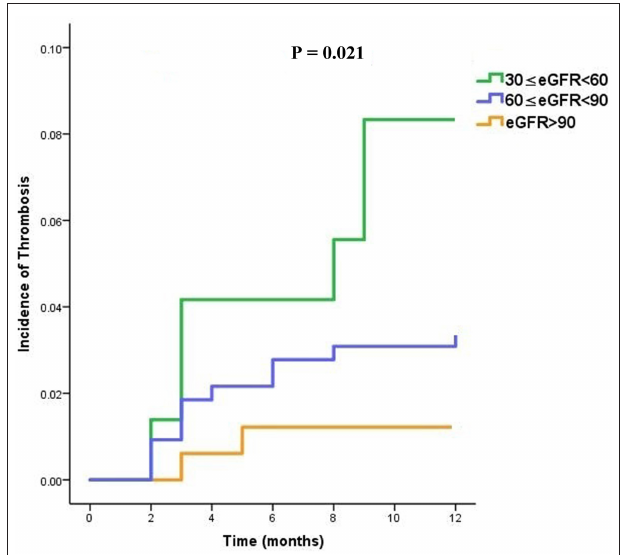
FIGURE 2 | Time to thrombosis (TTT) curves in dabigatran treated patients, stratified into three subgroups (moderate, mild, and normal) according to the eGFR category.